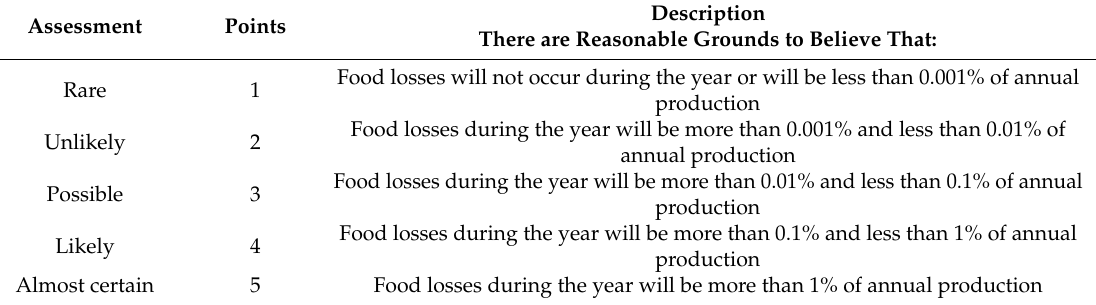
Table 2. Food loss risk probability